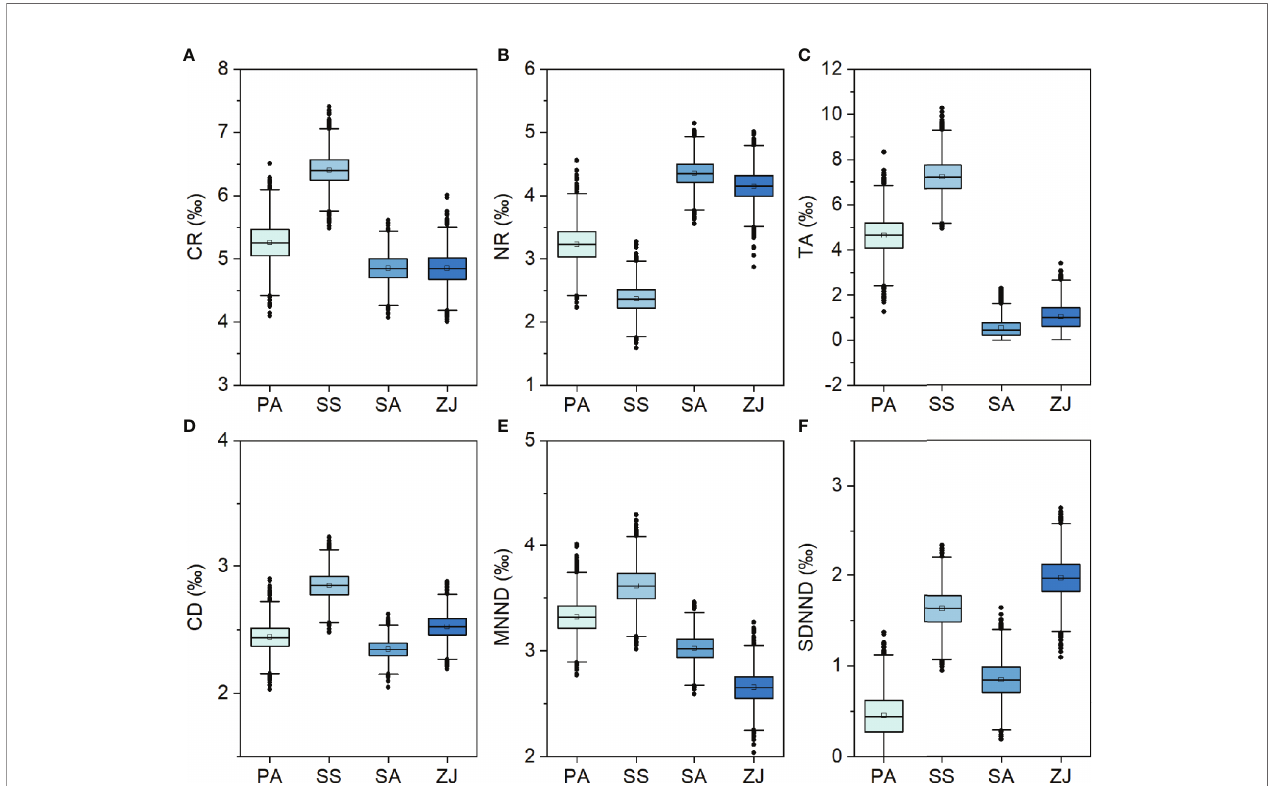
FIGURE 5 | Boxplots representing Bayesian model estimates for six Layman community metrics: (A) the d 13 C range ( CR ), (B) the d 15 N range ( NR ), (C) the total area ( TA ), (D) the mean distance to the centroid ( CD ), (E) the mean nearest-neighbor distance ( MNND ), and (F) the standard deviation of the nearest-neighbor distance ( SDNND ) across the Phragmites australis (PA), Suaeda salsa (SS), Spartina alterni fl ora (SA), and Zostera japonica seagrass (ZJ) habitats along the coastal topographic gradient in the Yellow River Delta